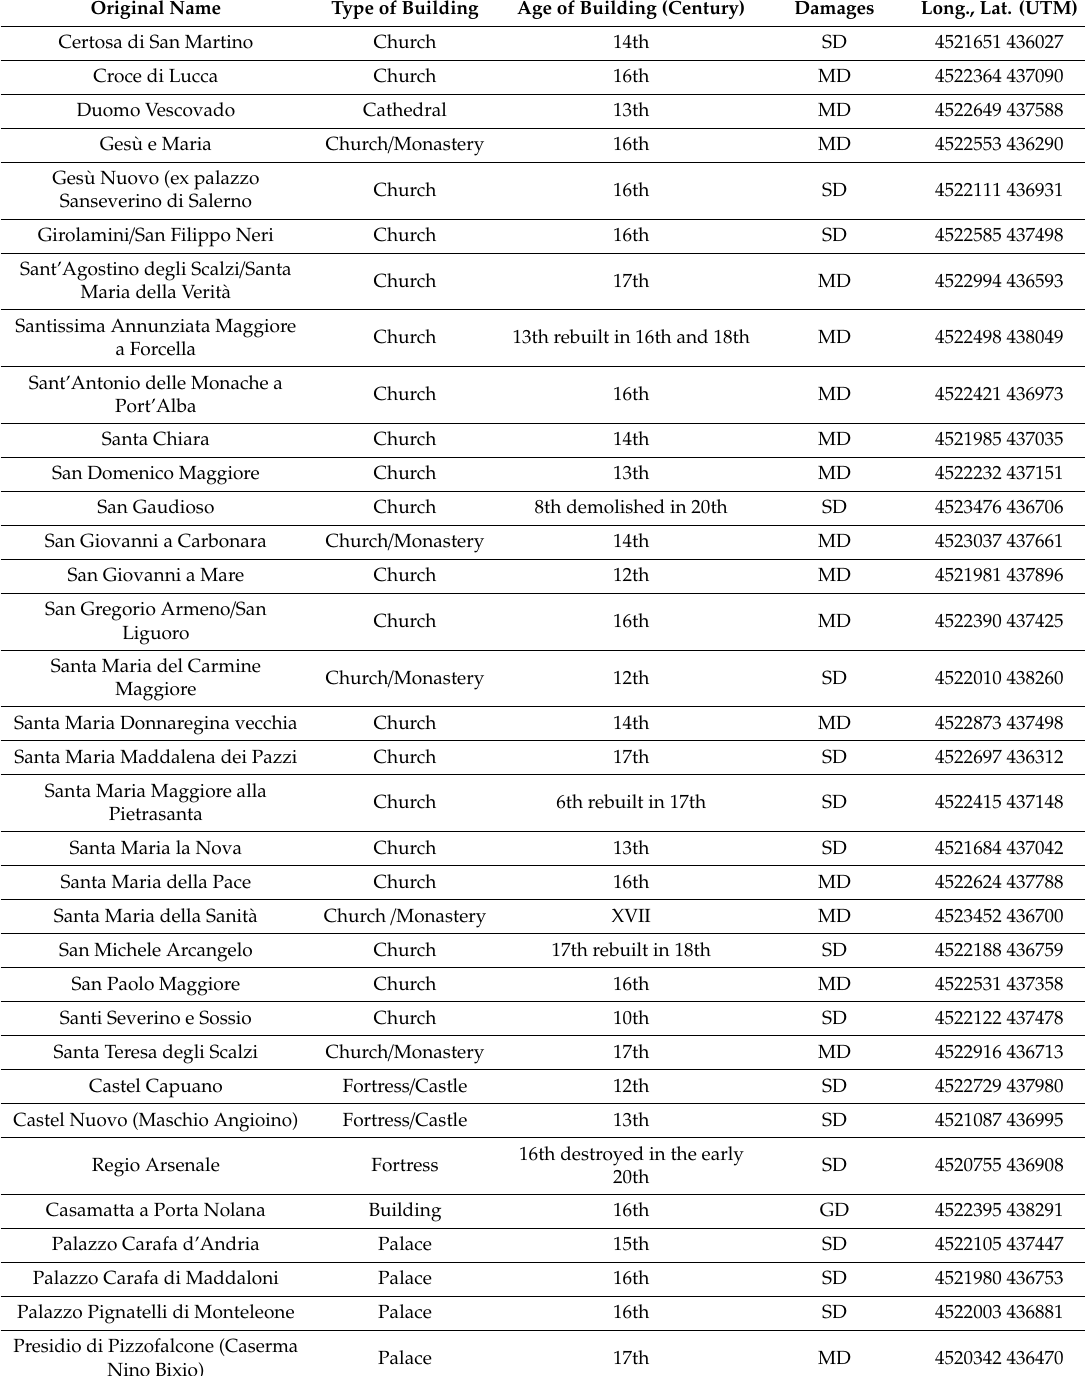
Table A4. The historical buildings of Naples damaged by the 1694 earthquake [2,43]. MD = Minor Damage; SD = Serious Damage; GD = Great